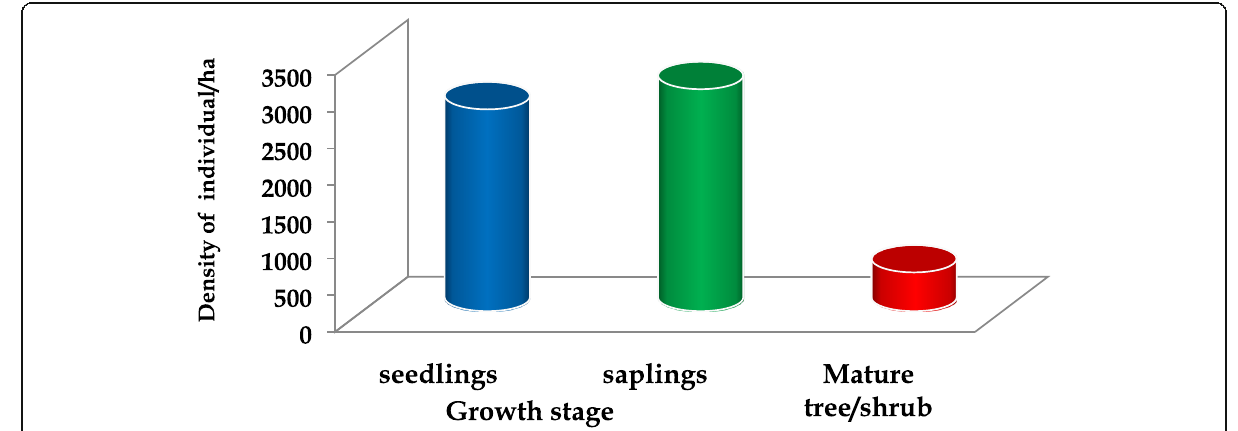
Fig. 8 Density per hectare of seedlings, saplings, mature of woody species (trees/shrubs)